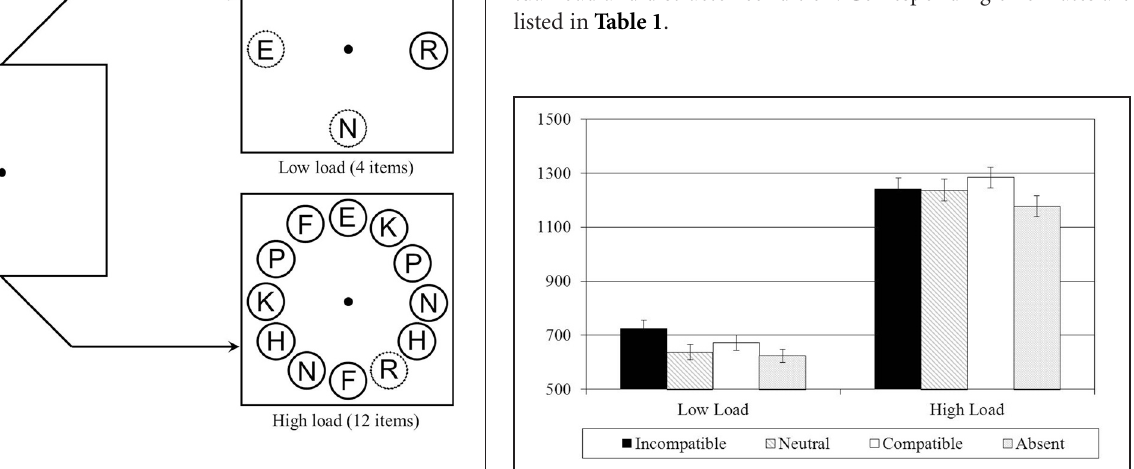
until a response was made. Solid lines represent green circles, and dotted lines represent red circles as used in the actual experiment.